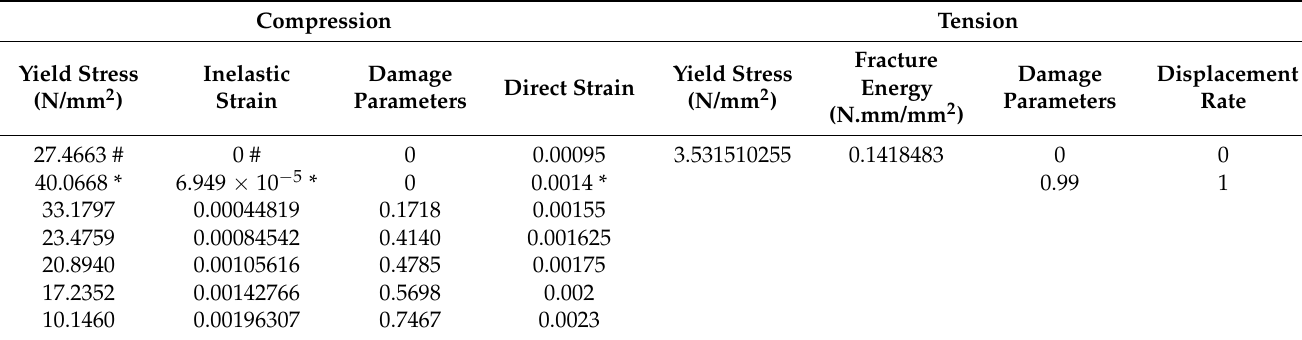
Table A2. Concrete compression and tension damage data for the control